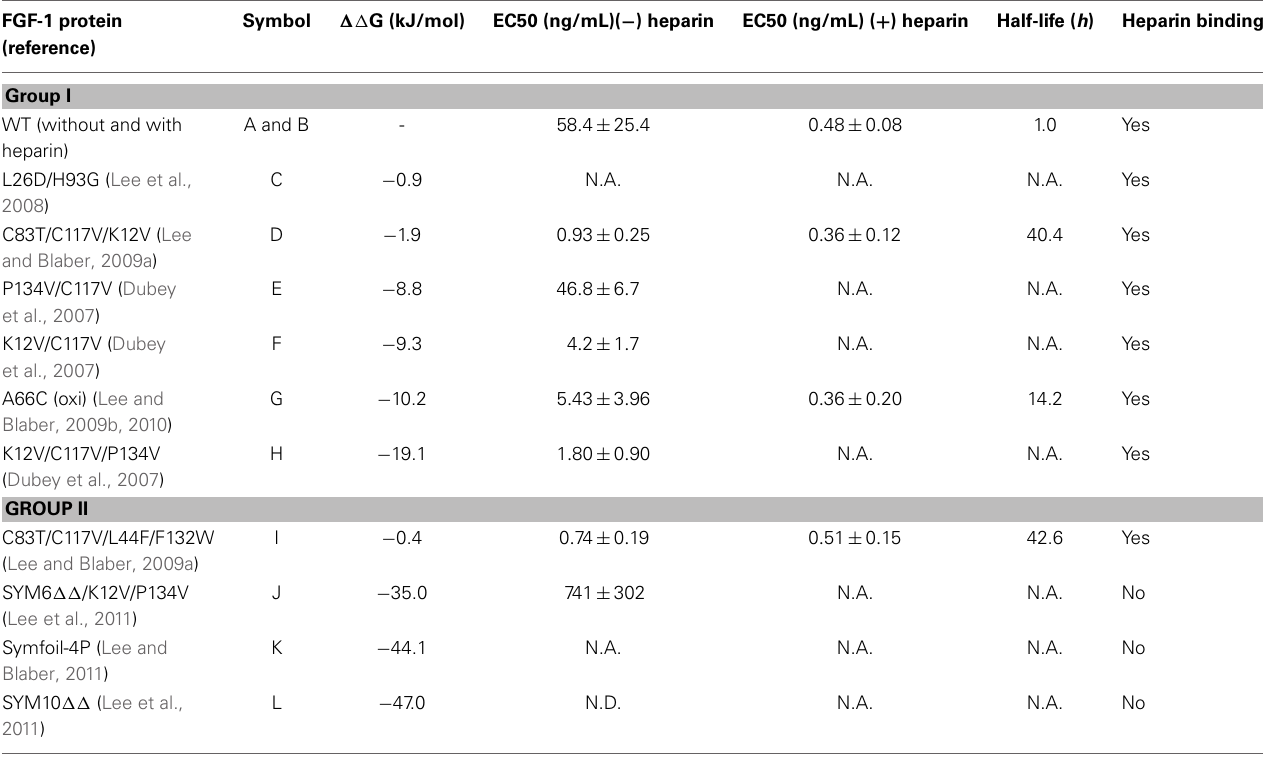
Table 1 | Summary of conformational stability ( (cid:2)(cid:2) G) and biological activity (EC50, half-life, heparin binding) values for wildtype (WT) FGF-1 and its